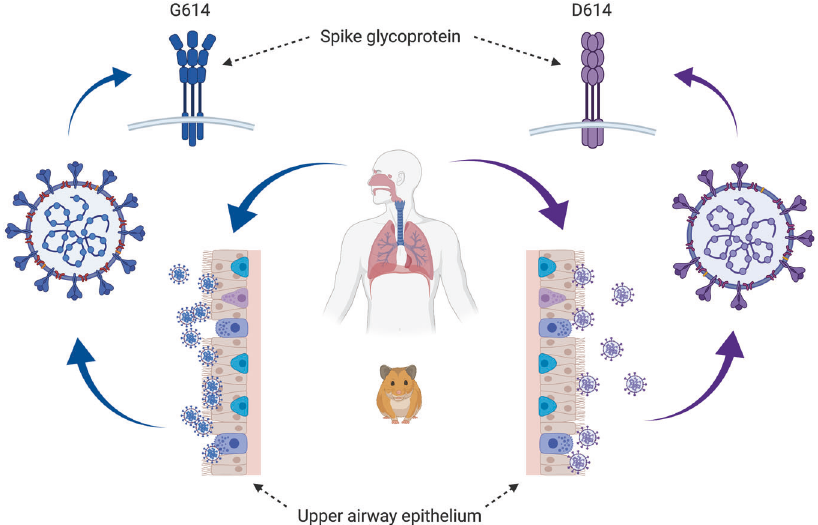
Fig. 1 D614G and SARS-CoV-2 transmissibility. The G614 virus variant (left) replicates more ef fi ciently than the ancestral D614 virus in tissues of the upper respiratory epithelium. The higher density of S protein trimers on the viral surface as well as the frequency of spikes in the open receptor-binding con fi guration may contribute to increased transmission of the D614G mutant